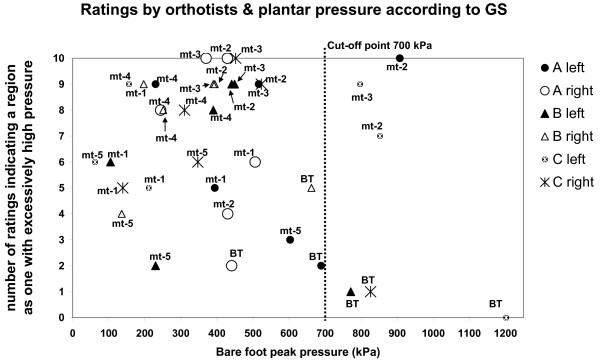
Ratings by orthotists. The distribution of ratings of orthotists who indicated a region as one with excessively high pressure, against the plantar pressure measured with the pressure platform (Gold Standard).